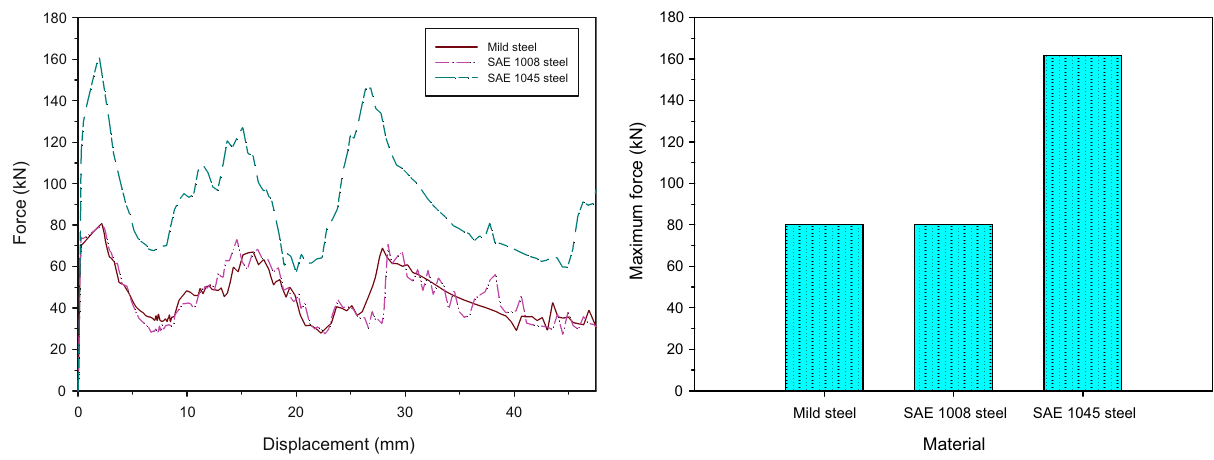
Figure 16: Force versus displacement generated during axial loading curve for three steel materials.